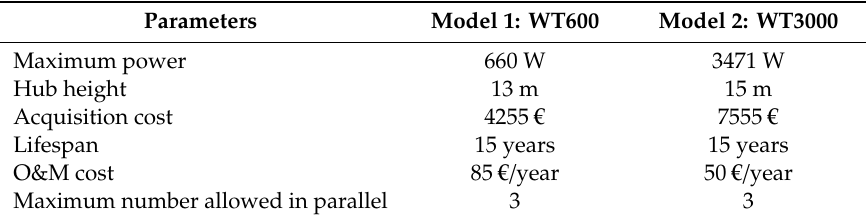
Table 6. Wind turbines used in optimization.